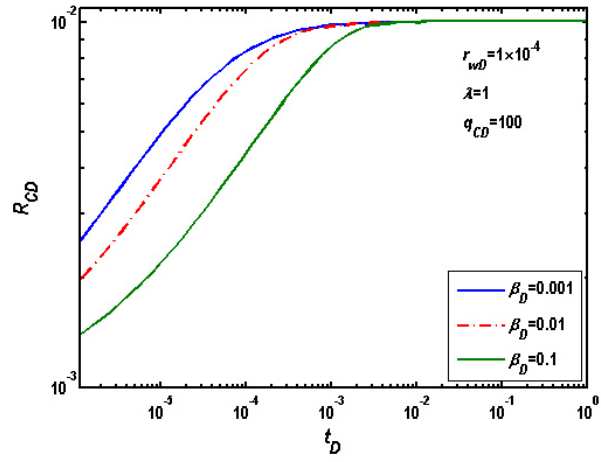
Figure 5. Time-dependent critical radius ( R CD ) for different values of the inertial force coefficient β D